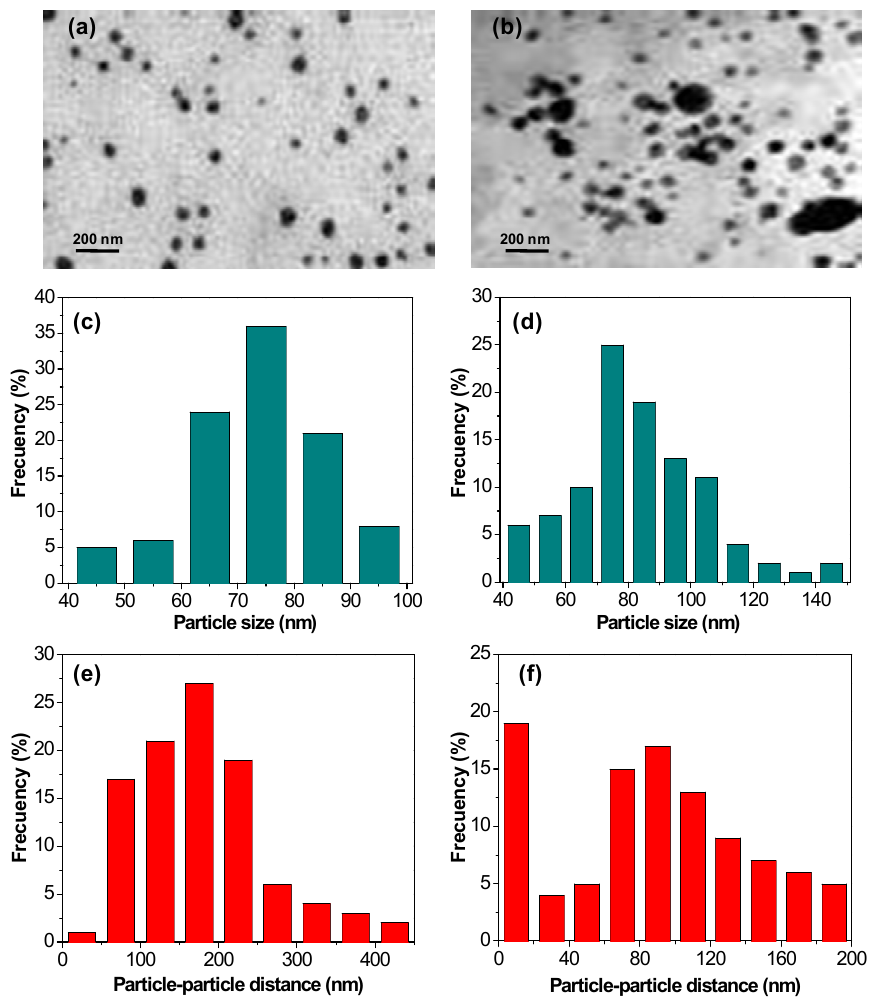
Figure 2. Top : TEM micrographs of PHB/ZnO nanocomposites with ( a ) 1.0 wt % and ( b ) 10.0 wt % nanoparticle content; Middle and bottom : Particle size and particle-particle distance distribution of ZnO nanoparticles in the nanocomposites with 1.0 wt % ( c , e ) and 10.0 wt % ( d , f ) nanofiller loading.